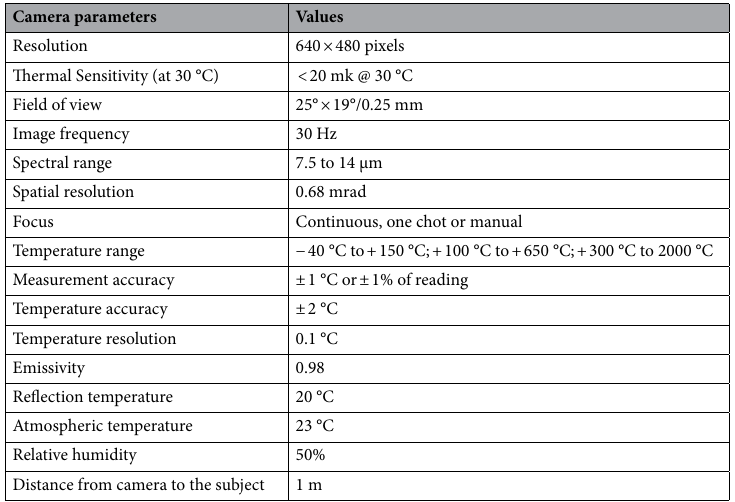
Table 1. Technical specifications of the FLIR T650SC infrared camera used to acquire the patients’ thermal